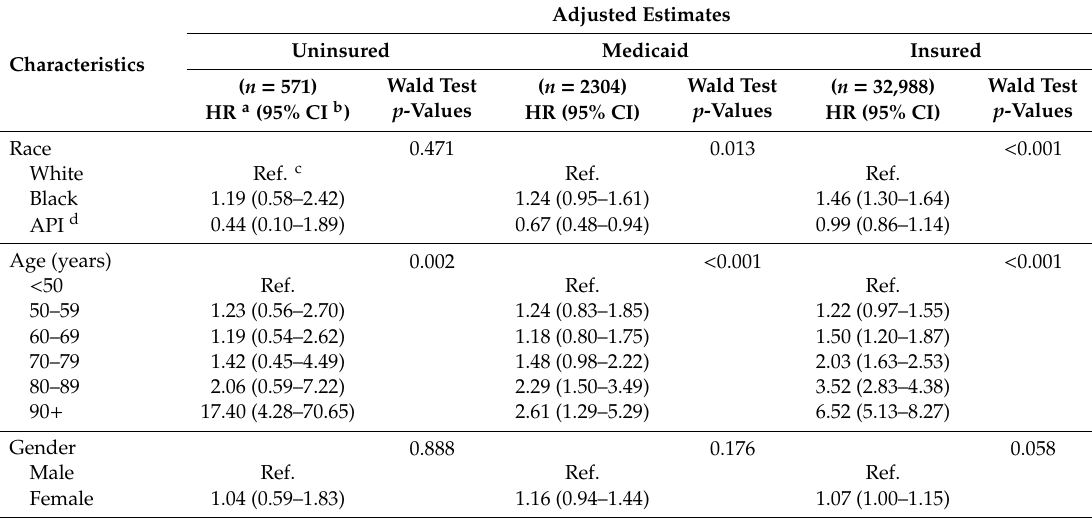
Table 2. Adjusted hazard ratios for cause-specific 5-year survival stratified by insurance status among adult patients diagnosed with bladder cancer (SEER 2007–2015).